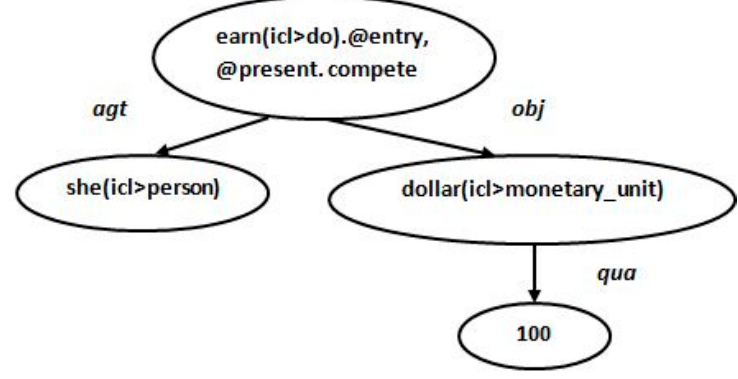
Figure 6. UNL graph for the UNL expression